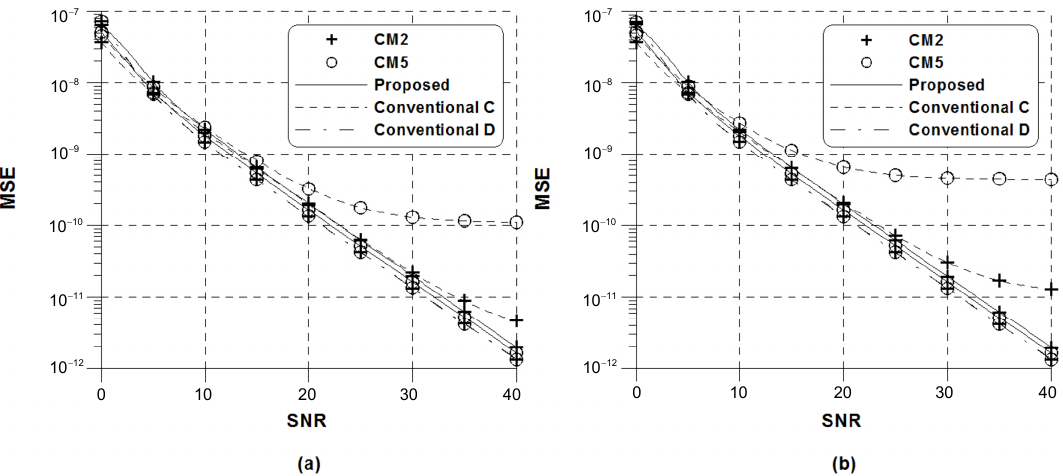
Figure 3. MSE of the conventional and proposed frequency estimators in DRM mode A: ( a ) ∆ s = 50 ppm; ( b ) ∆ s = 100